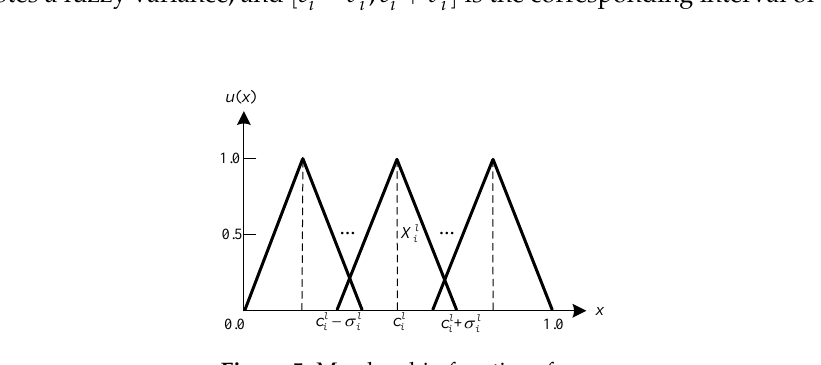
Figure 5. Membership functions for x.